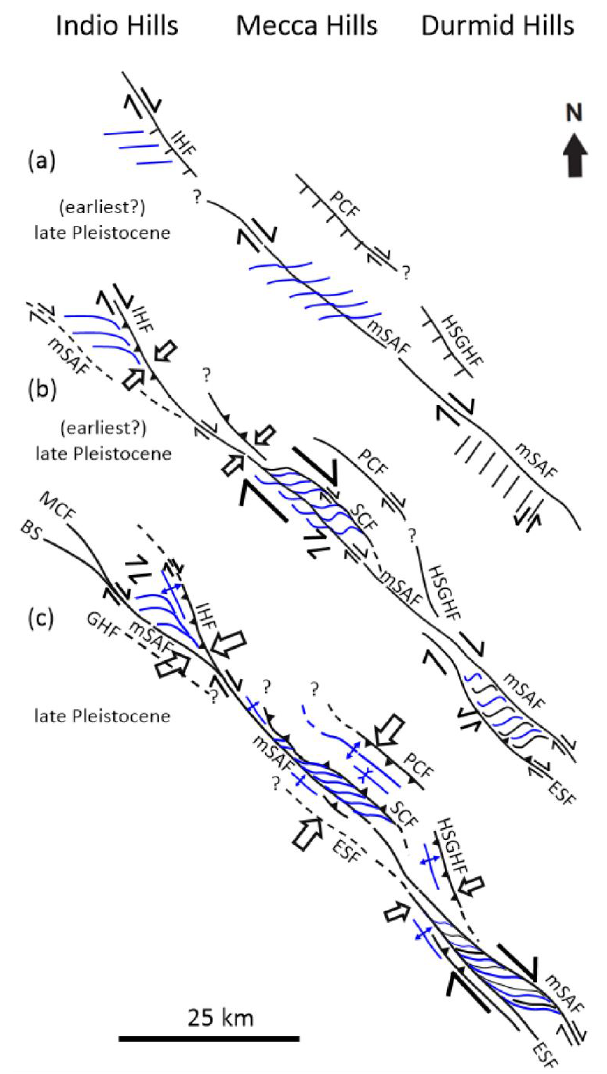
Figure 8. Kinematic evolution, timing, and along-strike correlation of the Indio Hills, Mecca Hills, and Durmid Hills uplift domains and bounding master faults in the Coachella Valley, southern California. We present a progressive kinematic evolution from (a) distributed, through (b) partly partitioned, to (c) advanced partitioned strain events. See text for further explanation. Black lines are faults (full or stippled). Blue lines are fold axial traces. Wide arrows indicate main shortening direction, and half-arrows indicate lateral (strike- slip) shearing. Abbreviations: BS: Banning strand; ESF: East Shore- line fault; GHF: Garnet Hill fault; HSGHF: Hidden Springs–Grotto Hills fault; IHF: Indio Hills fault; mSAF: main San Andreas fault; MCF: Mission Creek fault; PCF: Painted Canyon fault; SCF: Skele- ton Canyon